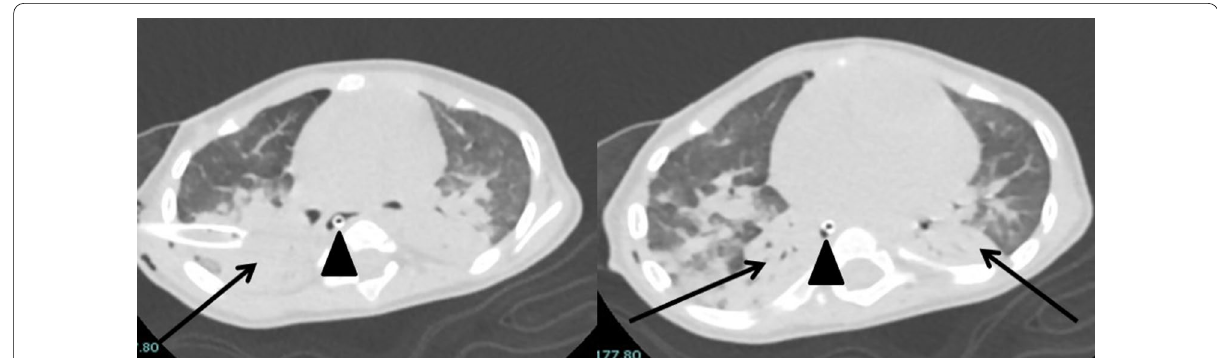
Fig. 8 A 8‑month‑old female baby, known case of Down syndrome and congenital heart disease (VSD, ASD, and PDA), presented by acute dyspnea with severe respiratory manifestation. CT shows bilateral upper and lower lobar posterior consolidation and atelectasis (note chest tube is seen in the right lung due to pneumothorax (resolved)), picture atypical for COVID, and CT severity score was 15/20. Note : the nasogastric tube is seen slightly deviated to the right (black triangle)